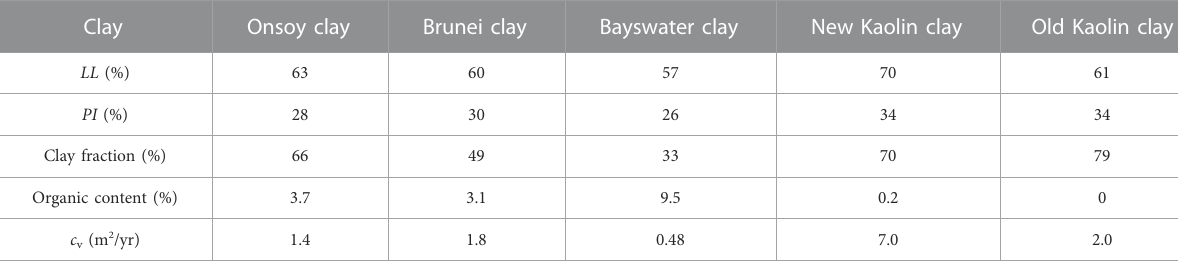
TABLE 1 Summary of soil